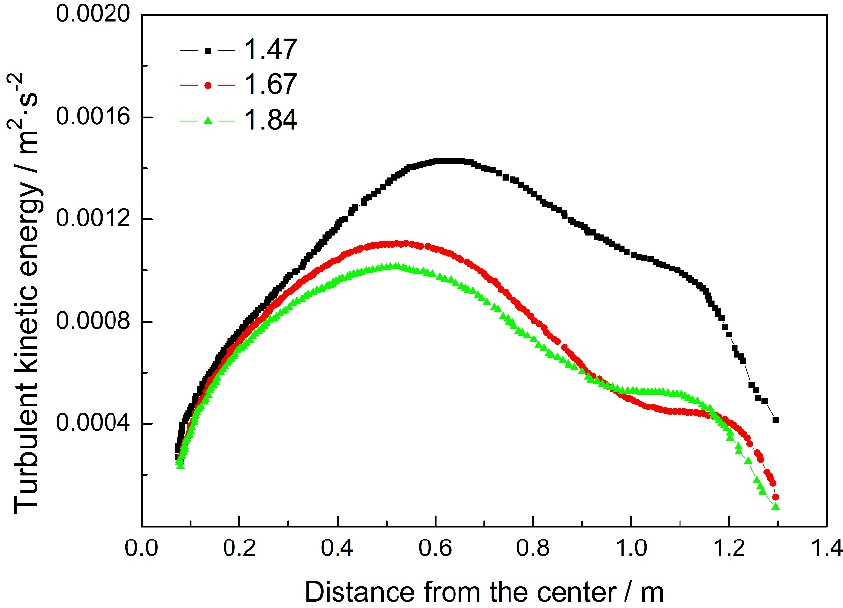
Figure 9. Influence of the side-hole aspect ratio on the turbulent kinetic energy at free surface.